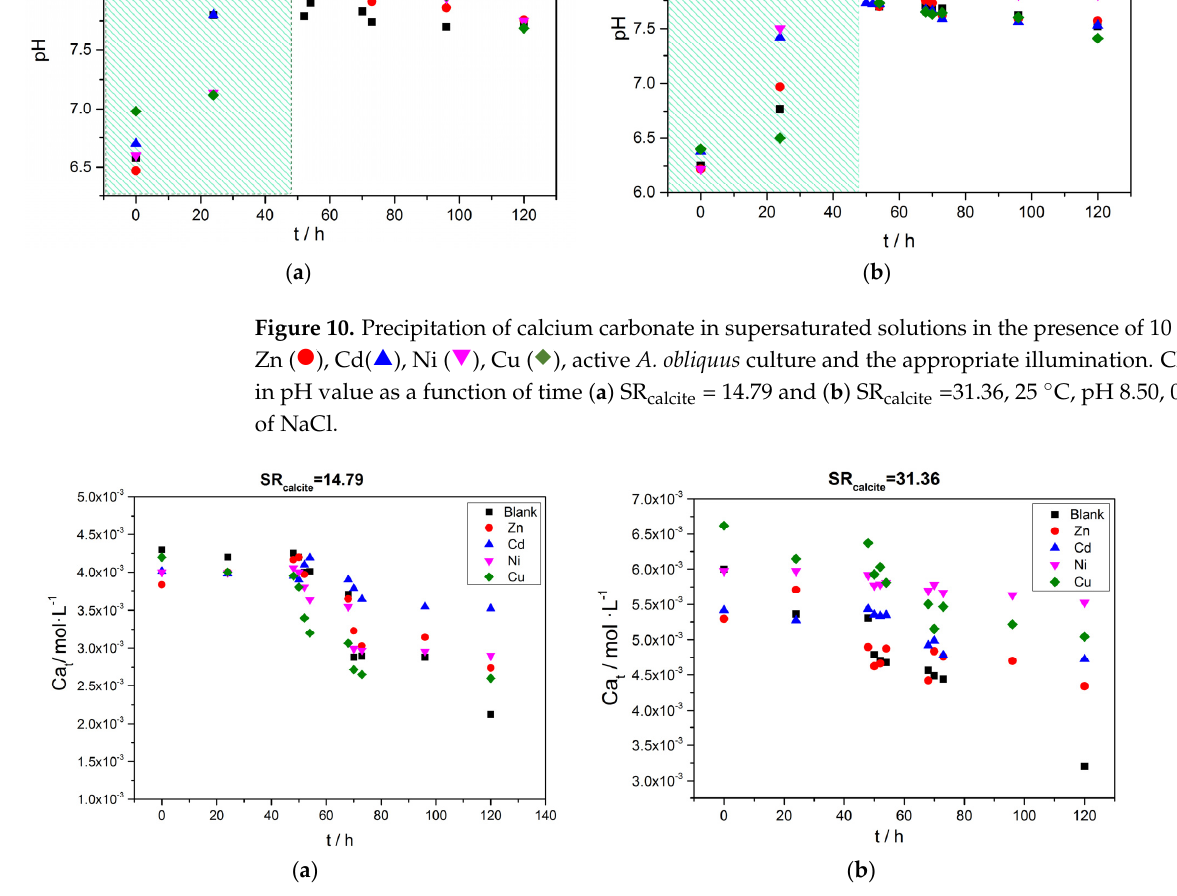
Figure 11. Precipitation of calcium carbonate in supersaturated solutions in the presence of 10 µ M Figure 10. Precipitation of calcium carbonate in supersaturated solutions in the presence of 10 μ M Figure 10. Precipitation of calcium carbonate in supersaturated solutions in the presence of 10 μ M Figure 10. Precipitation of calcium carbonate in supersaturated solutions in the presence of 10 μ M Figure 10. Precipitation of calcium carbonate in supersaturated solutions in the presence of 10 μ M of Zn (  ), Cd(  ), Ni (  ), Cu (  ), active A. obliquus culture and the appropriate illumination. of Zn (  ), Cd(  ), Ni (  ), Cu (  ), active A. obliquus culture and the appropriate illumination. of Zn (  ), Cd(  ), Ni (  ), Cu (  ), active A. obliquus culture and the appropriate illumination. of Zn (  ), Cd(  ), Ni (  ), Cu (  ), active A. obliquus culture and the appropriate illumination. of Zn ( Change in pH value as a function of time ( a ) SR calcite = 14.79 and ( b ) SR calcite =31.36, 25 °C, pH 8.50, Change in pH value as a function of time ( a ) SR calcite = 14.79 and ( b ) SR calcite =31.36, 25 °C, pH 8.50, Change in pH value as a function of time ( a ) SR calcite = 14.79 and ( b ) SR calcite =31.36, 25 °C, pH 8.50, Change in pH value as a function of time ( a ) SR calcite = 14.79 and ( b ) SR calcite =31.36, 25 °C, pH 8.50, 0.15 M of 0.15 M of NaCl. 0.15 M of NaCl. 0.15 M of NaCl.